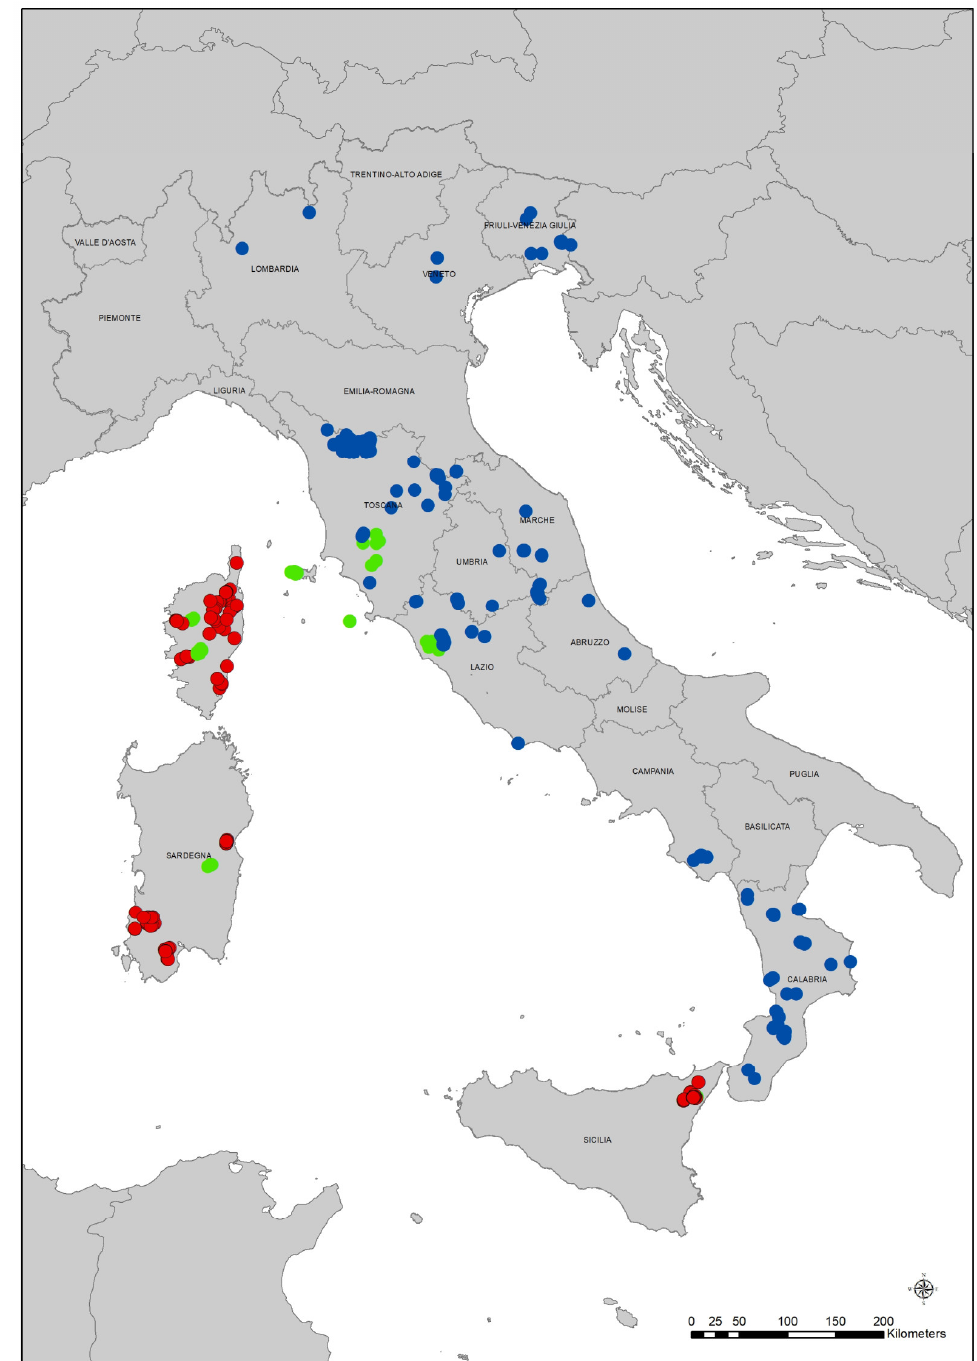
Figure 1. Alnus glutinosa communities in Italy and Corsica grouped according to Cluster Analysis (at the level of alliance and sub-alliance). Red dots: Hyperico hircini-Alnenion glutinosae ; Green dots: Struthioptero-Alnenion glutinosae ; Blue dots: Ligustro vulgaris-Alnion glutinosae .